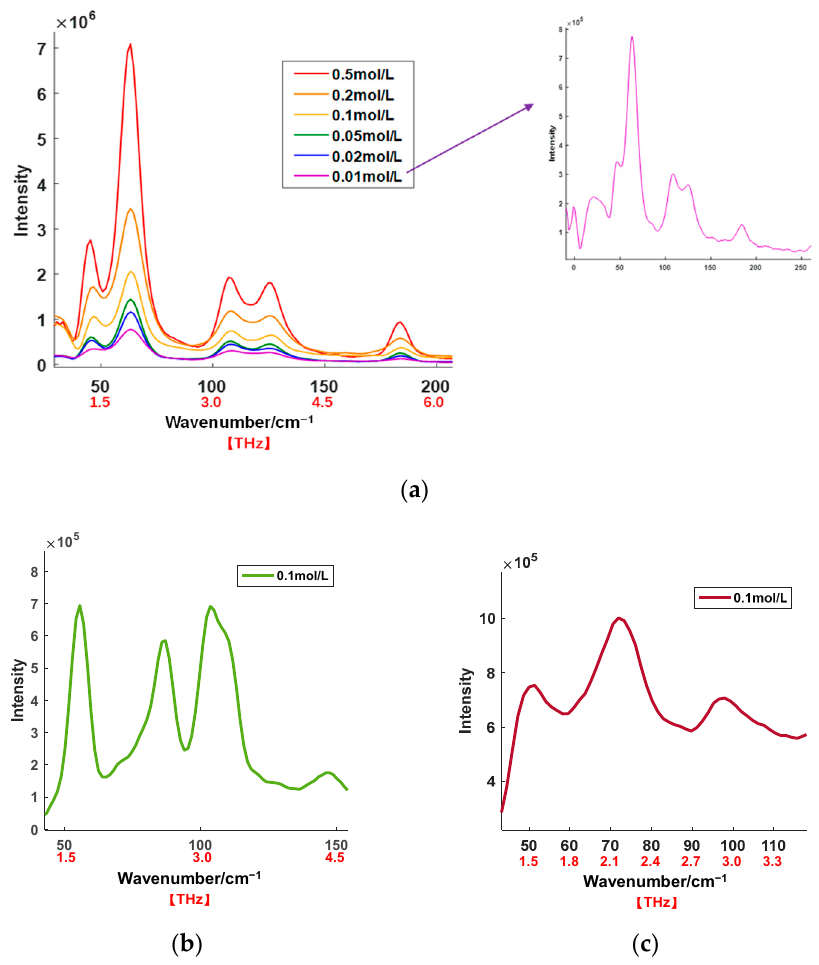
Figure 6. ( a ) Terahertz Raman spectra of salicylic acid aqueous solutions; ( b ) terahertz Raman spectrum of gallic acid aqueous solution; ( c ) terahertz Raman spectrum of indomethacin aqueous solution 3.6. Wide band terahertz Raman spectroscopy experiment.